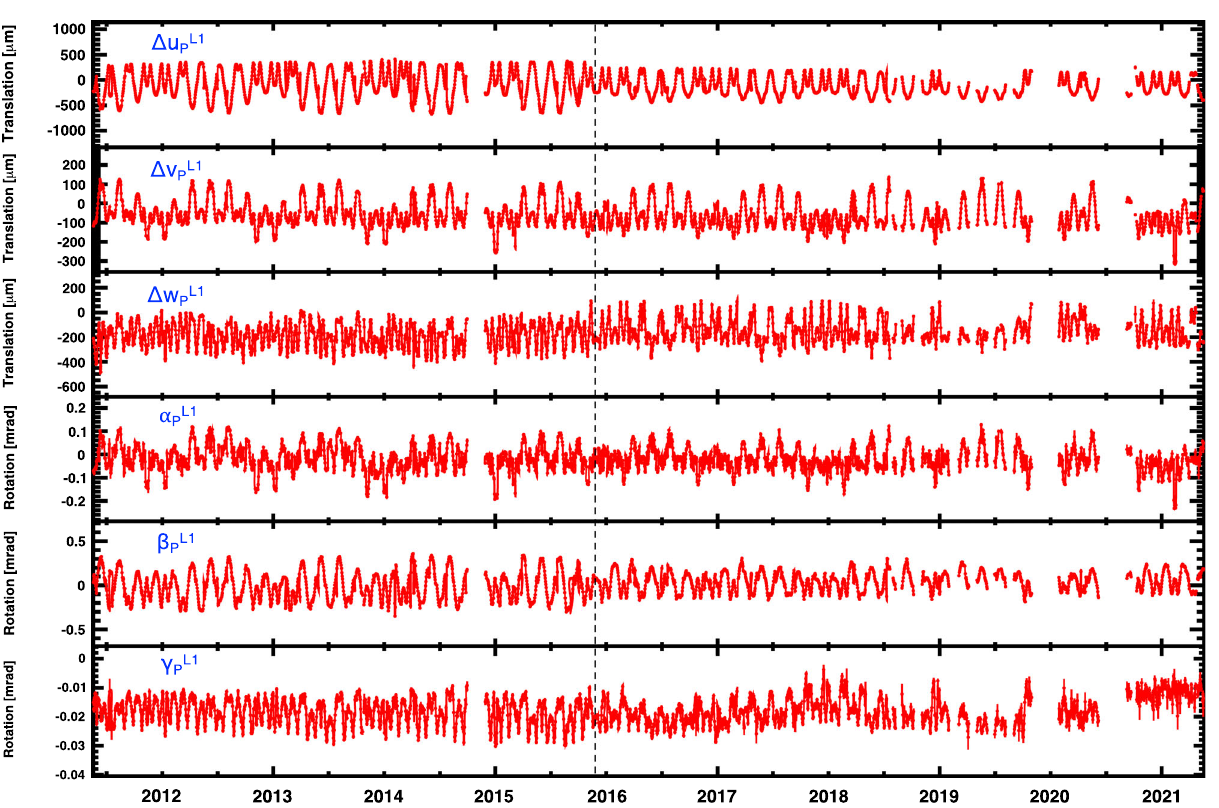
Fig. 16 The variations of the dynamic alignment parameters of L1 over 10 years from May 20, 2011 to May 20, 2021. Note the change in behavior starting from the end of 2015, which is due to the installation of a thermal blanket on the port ( − x ) side of AMS on Oct 28, 2015 (indicated by the vertical dashed